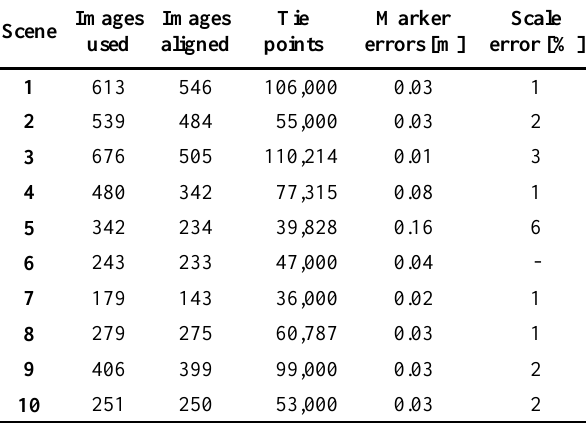
Table 1: Number of images that were used as input, number of images that could be aligned by SfM, number of tie points, marker errors and scale errors.